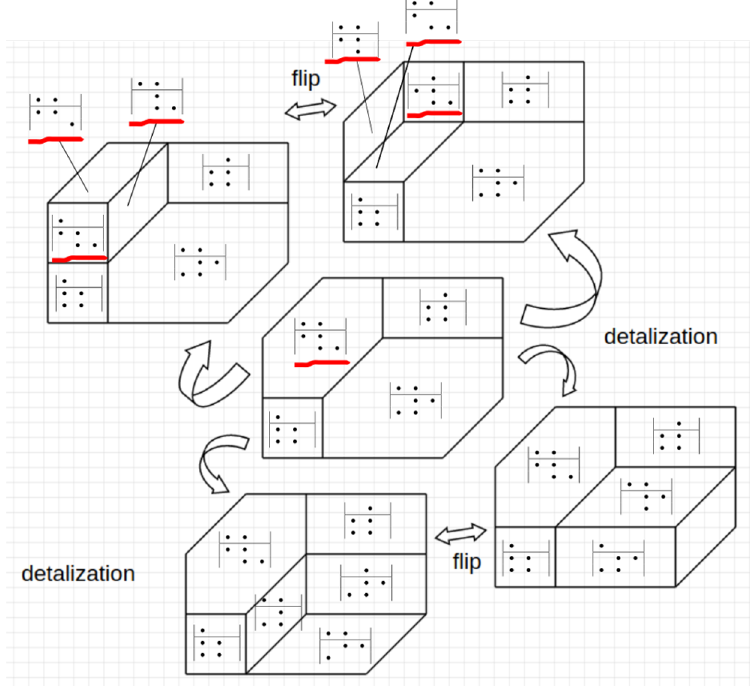
Figure 17 . Detalization of (cid:30) 1 ; 1 , applied once to each of its smaller